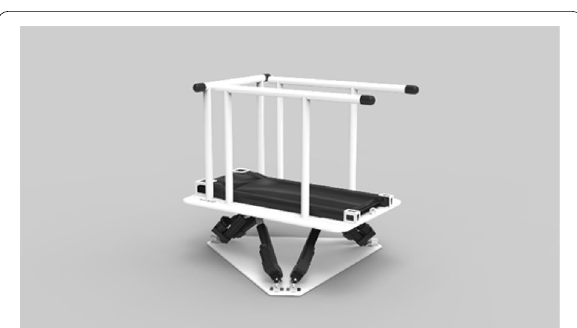
Figure 3 Structure of